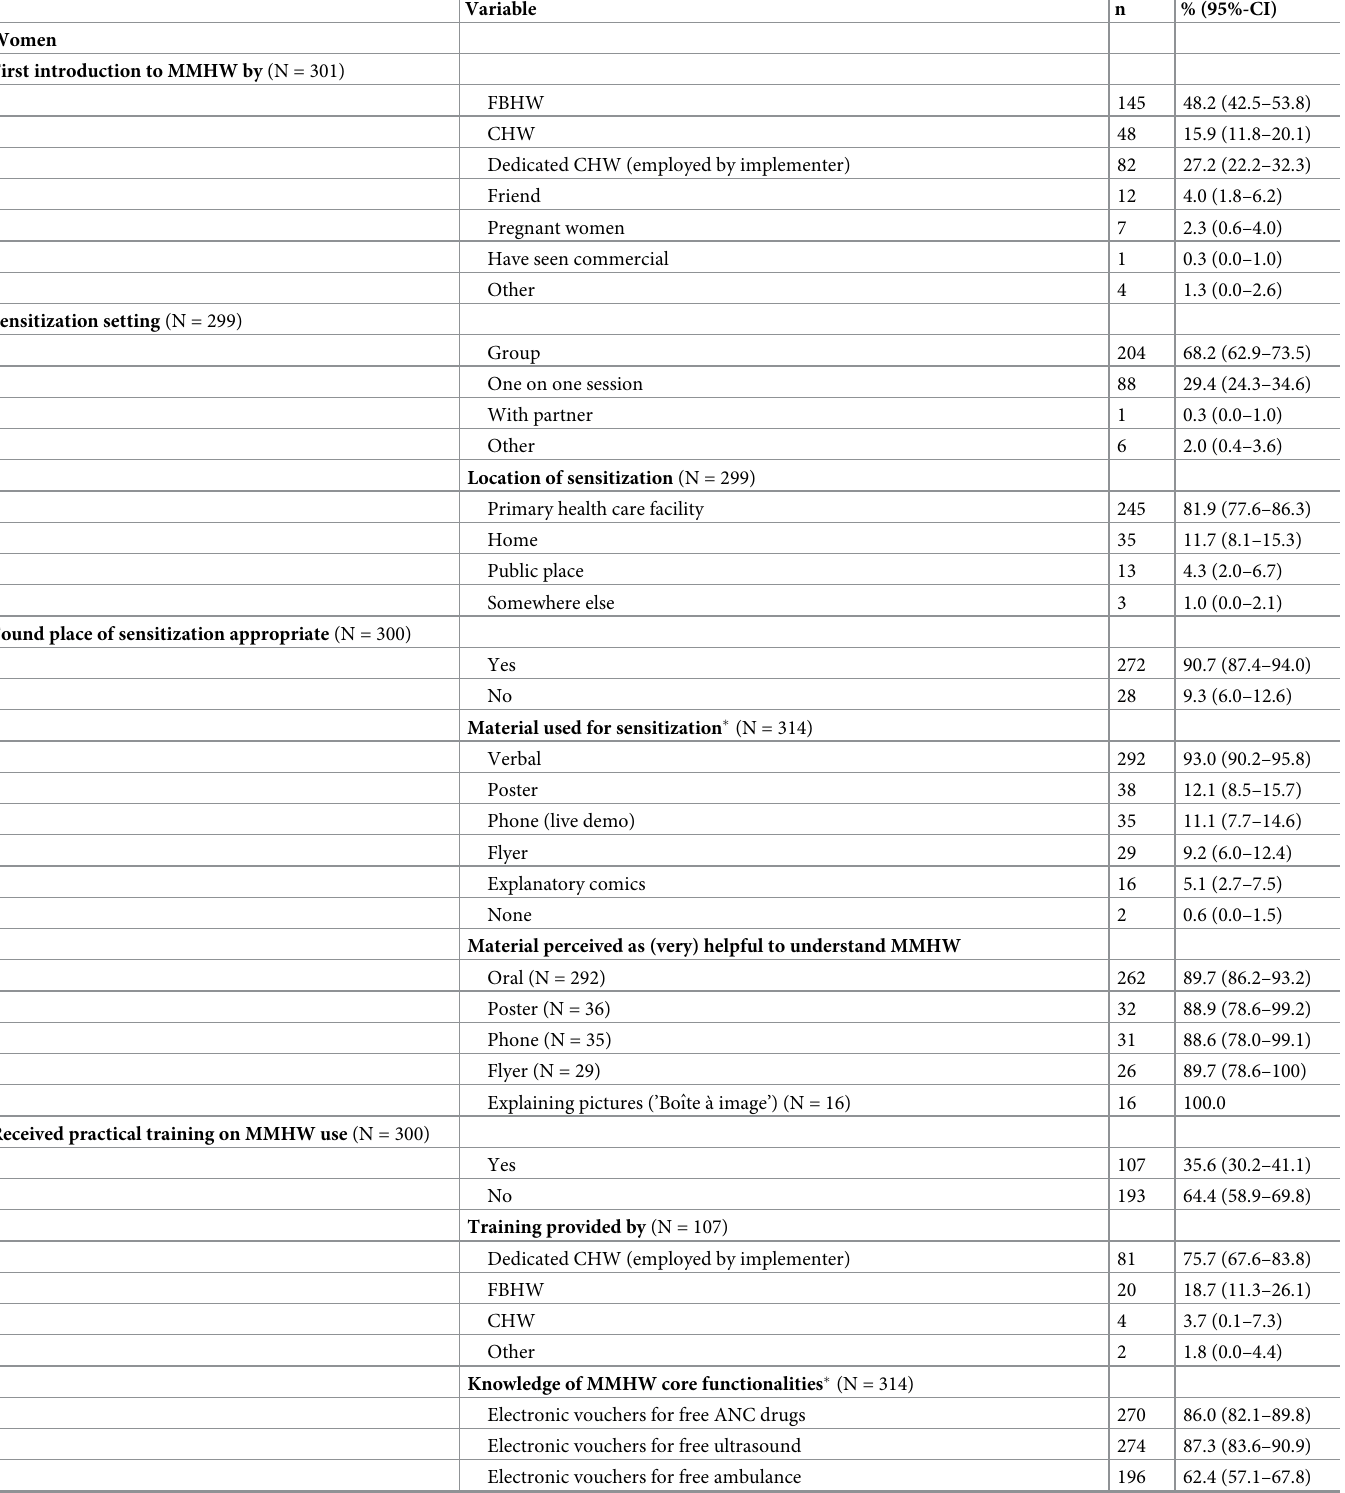
Table 2. Characteristics of target group sensitization activities and their perception among